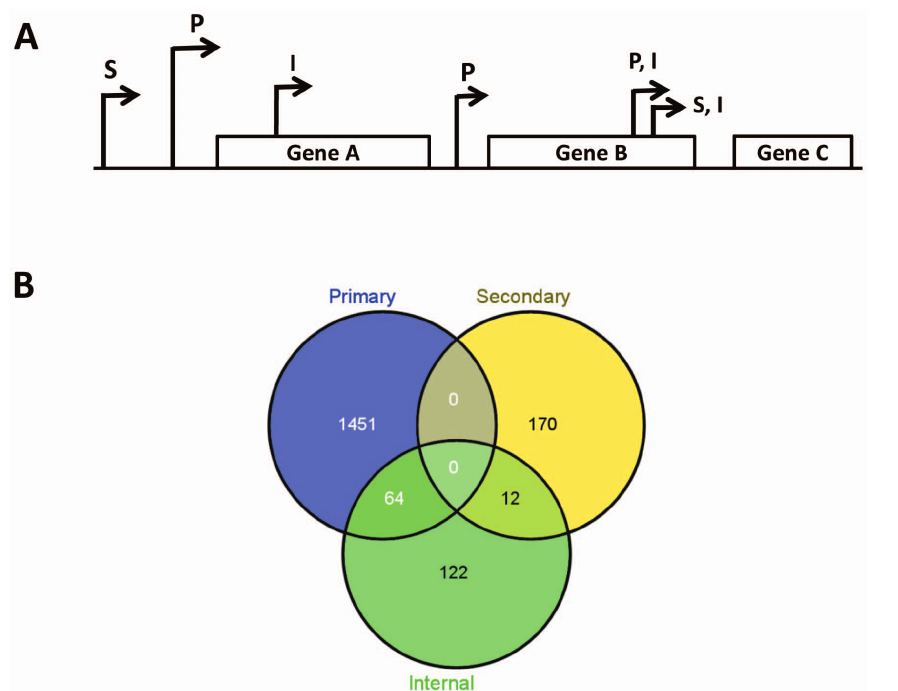
Figure 1. Annotation of TSSs. (A) TSSs were defined as primary (P), secondary (S) or internal (I). Primary TSSs were identified as having higher mapped read counts relative to secondary TSSs. Internal TSSs were located within the coding region (CDS) of a gene where a TSS was annotated for the gene immediately upstream. Primary and secondary internal TSSs (P,I and S,I respectively) were located within the CDS of a gene where there were no TSSs annotated for the gene immediately downstream. (B) Venn diagram showing overlap of S . Typhimurium LSP TSSs categories for all annotated genes.